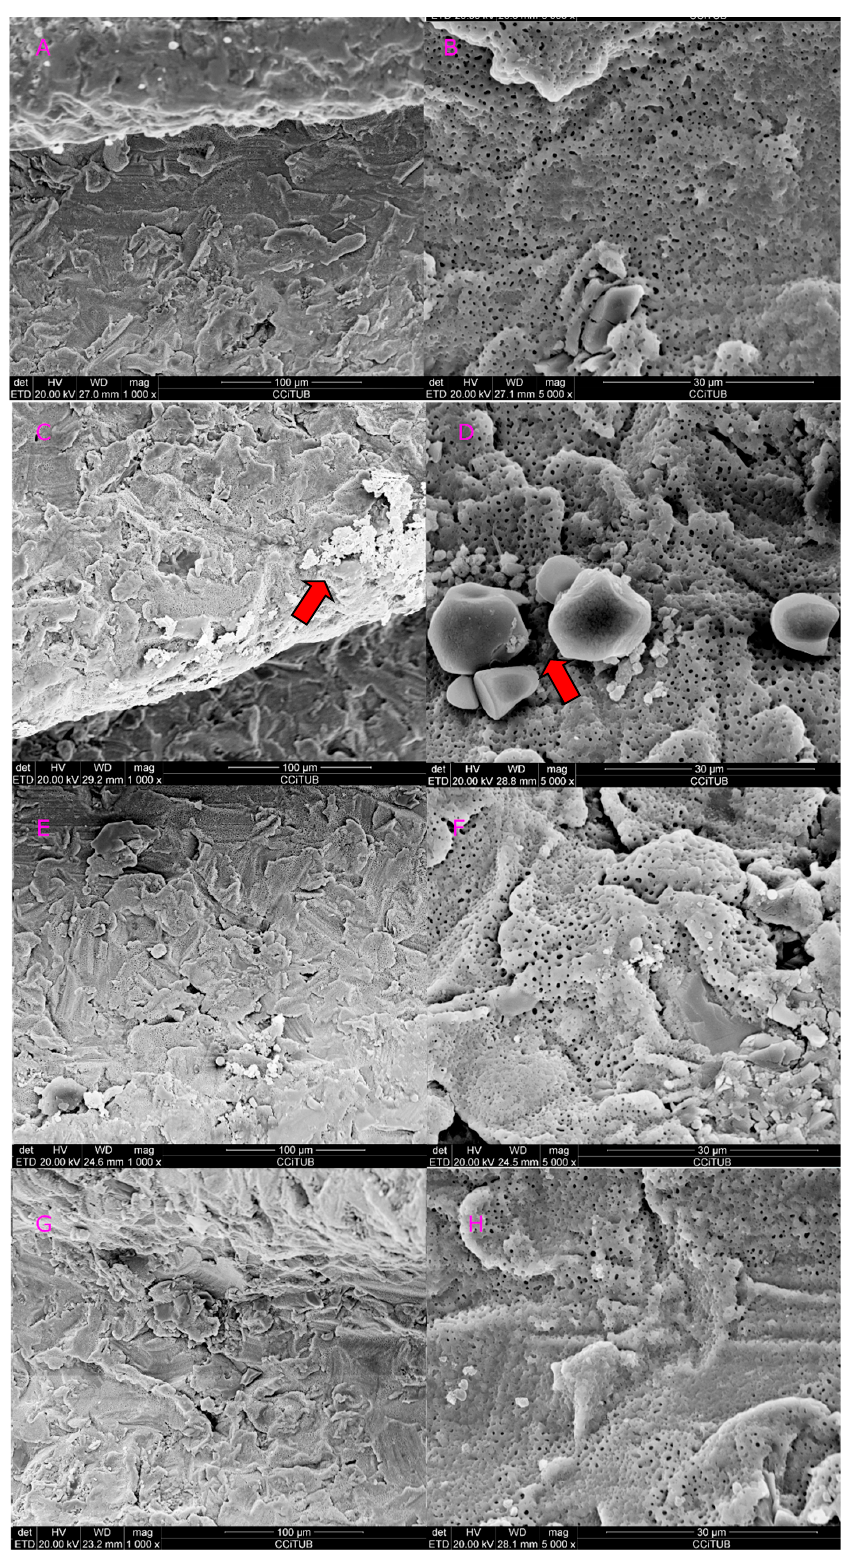
Figure 4. Control versus all 3 tips at 2.5 W. ( A ) Control at 1000× magnification; ( B ) control at 5000× magnification; ( C ) conical (RTF3-17 mm) tip at 1000× magnification; ( D ) conical tip (RTF3-17 mm) at 5000× magnification; ( E ) side firing tip (SFT8-18 mm) at 1000× magnification; ( F ) Side firing tip (SFT8-18 mm) at 5000× magnification; ( G ) cylindrical tip (MGG6-6 mm) at 1000× magnification; ( H ) cylindrical tip (MGG6-6 mm) at 5000× magnification.